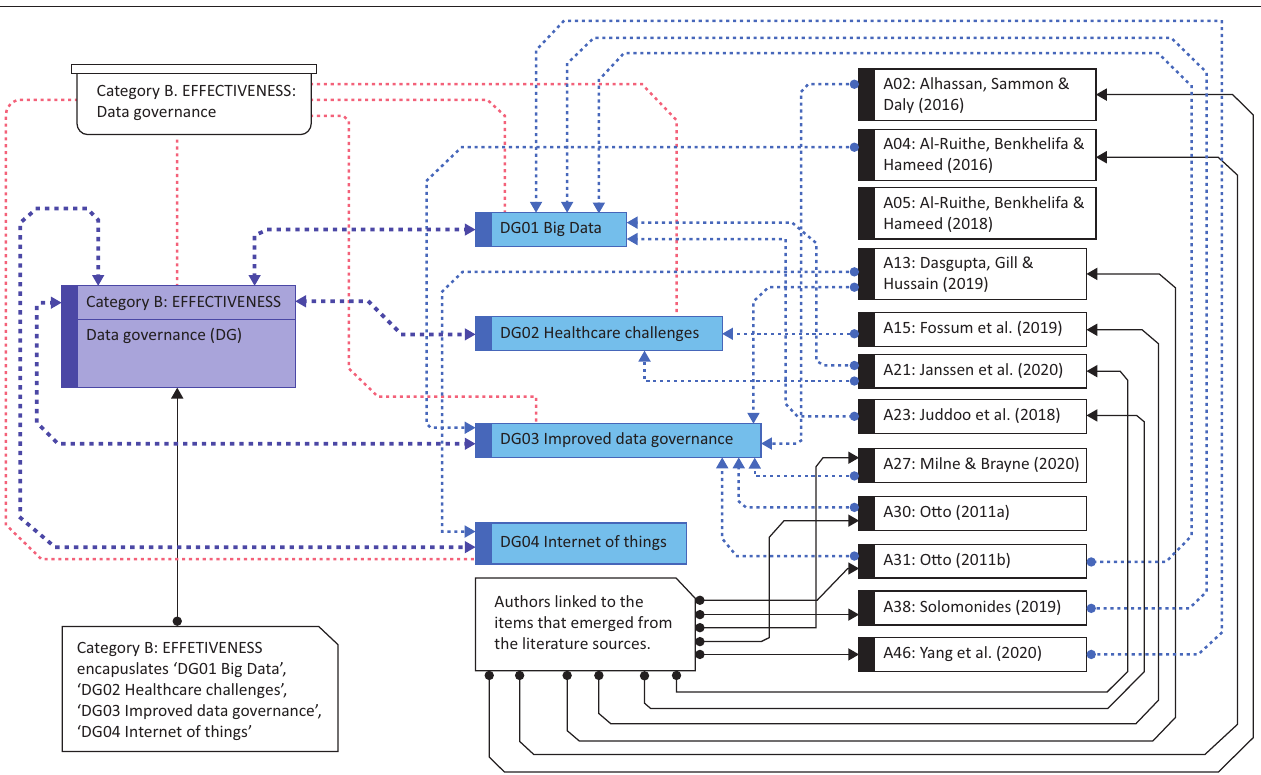
FIGURE 1: Network diagram for the category, themes, items and